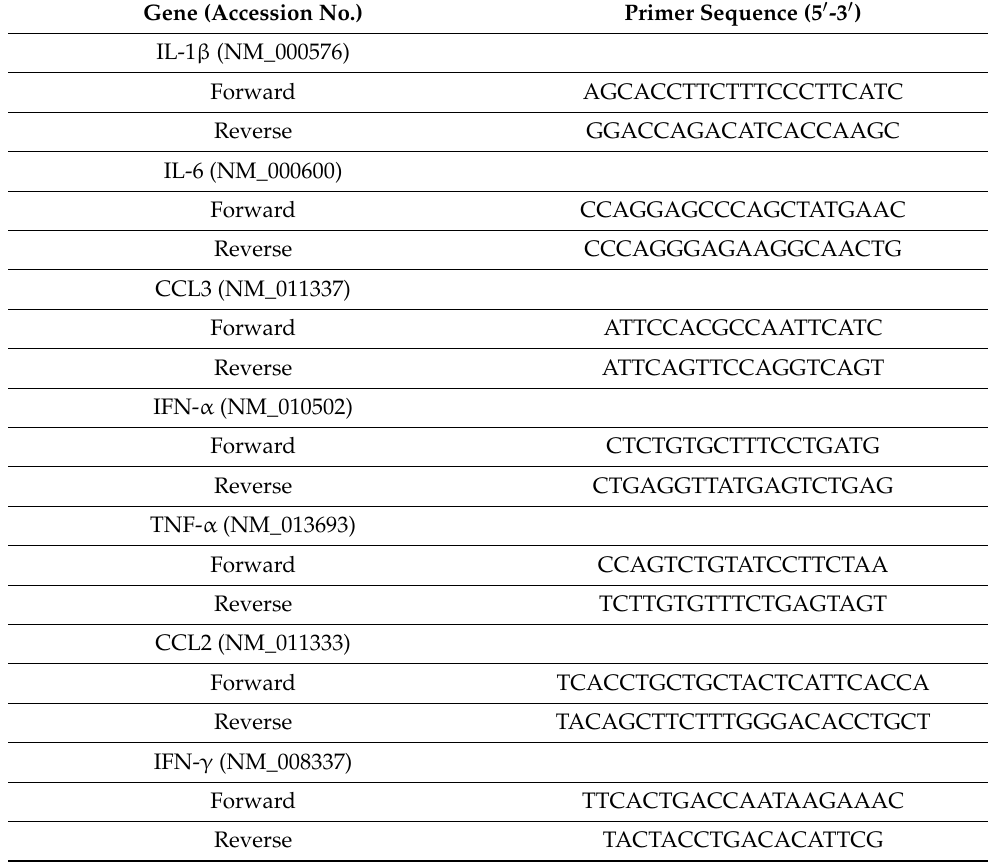
Table 1. Primer sequences used for